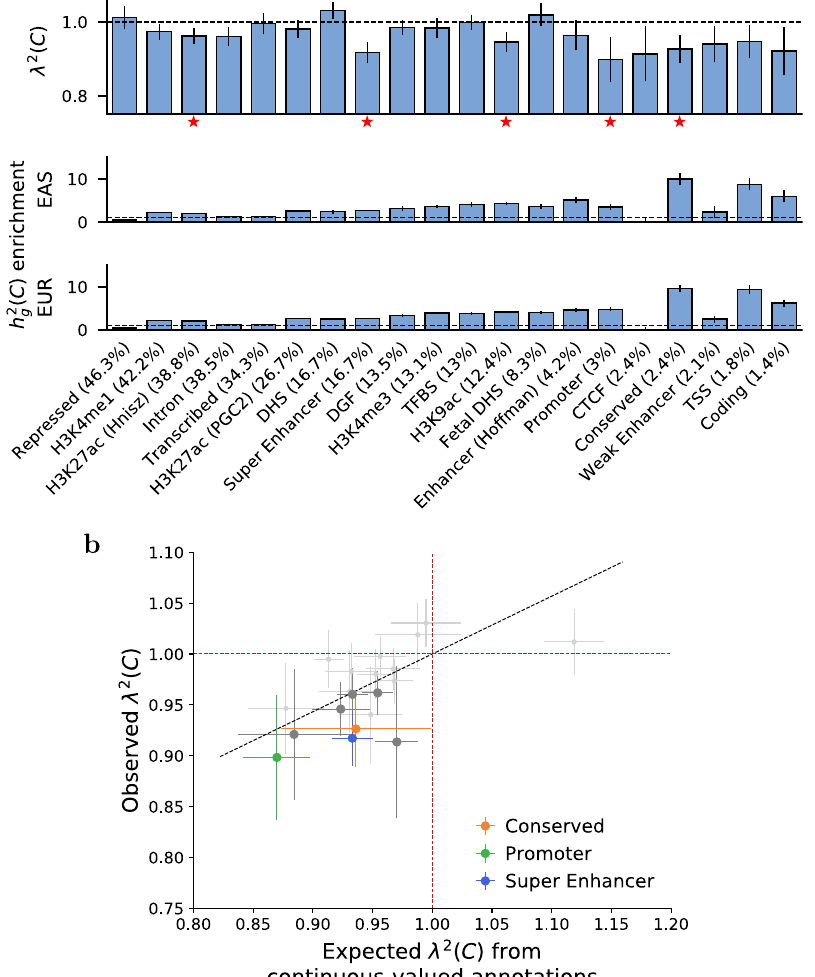
Fig. 3 S-LDXR results for 20 binary functional annotations across 31 diseases and complex traits. a We report estimates of the enrichment/depletion of squared trans-ethnic genetic correlation ( λ 2 ( C )), as well as population-speci fi c estimates of heritability enrichment, for each binary annotation (sorted by proportion of SNPs, displayed in parentheses). Results are meta-analyzed across 31 diseases and complex traits. Error bars denote ± 1.96 × standard error. Red stars ( ⋆ ) denote two-tailed p < 0.05/20. Numerical results are reported in Supplementary Data 16. b We report observed λ 2 ( C ) vs. expected λ 2 ( C ) based on 8 continuous-valued annotations, for each binary annotation. Results are meta-analyzed across 31 diseases and complex traits. Error bars denote± 1.96×standard error of the meta-analyzed λ 2 ( C ). P-values are obtained from the standard normal distribution. Annotations for which λ 2 ( C ) is signi fi cantly different from 1 ( p <0.05/20) are denoted in color (see legend) or dark gray. The dashed black line (slope = 0.57) denotes a regression of observed λ ( C ) − 1 vs. expected λ ( C ) − 1 with intercept constrained to 0. Numerical results are reported in Supplementary Data